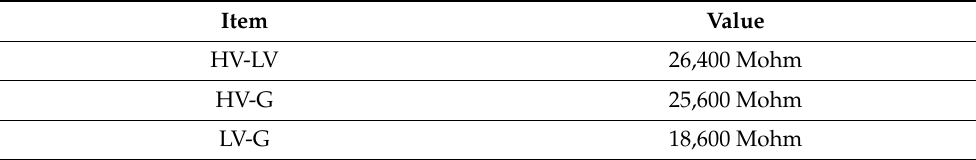
Table 3. The insulation resistance test.